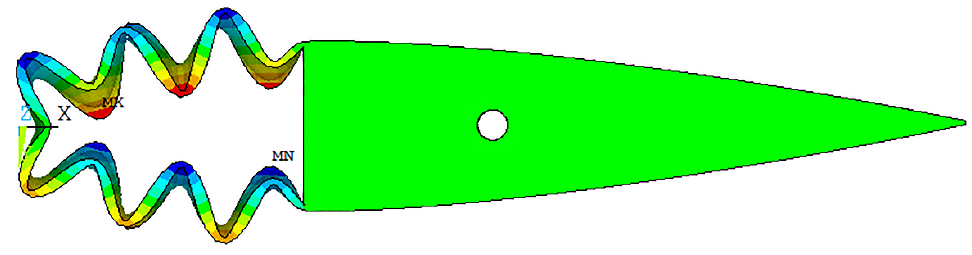
Figure 4. Ultrasonic de-icing vibration mode.